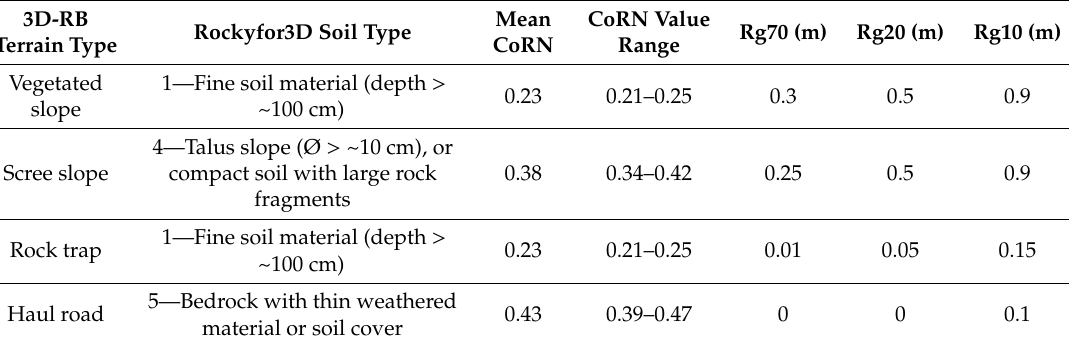
Table 4. Summary of input parameters used for the three-dimensional rigid-body impact model (3D-RB) numerical modelling.